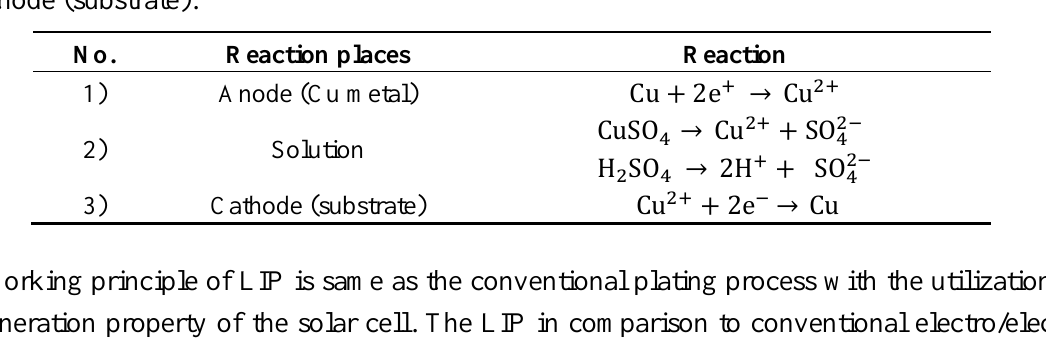
SO /CuSO ) and 2 4 4